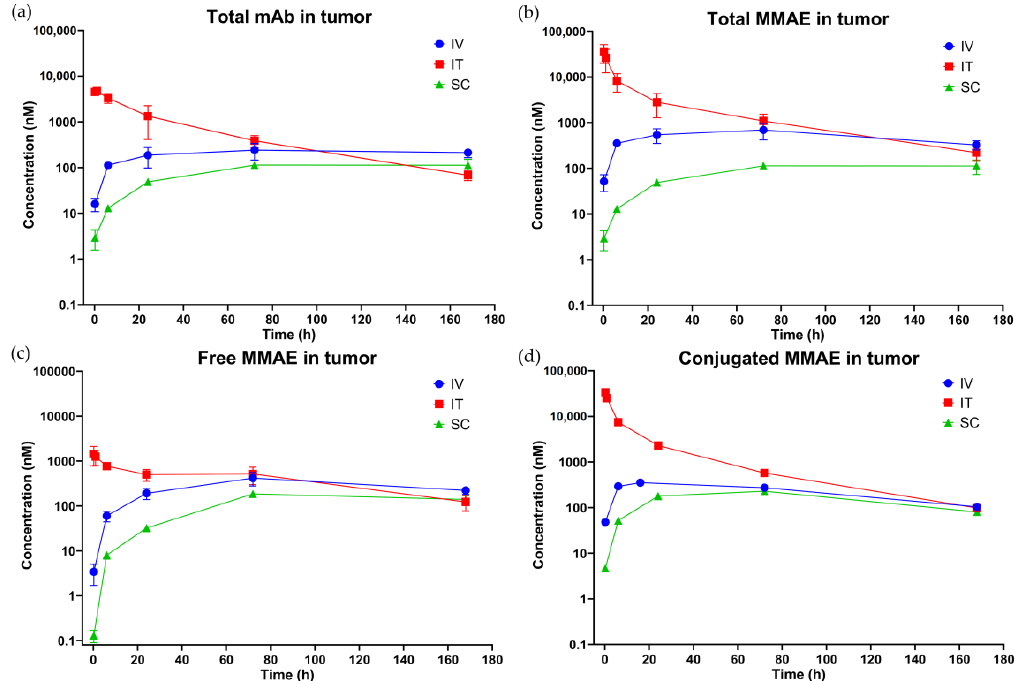
Figure 4. Observed tumor pharmacokinetics (PK) of ADC analytes in mice after intravenous (IV), intratumoral (IT), and subcutaneous (SC) administration of 10 mg/kg of T-vc-MMAE single dose. ( c ) unconjugated MMAE; and ( d ) conjugated MMAE in the